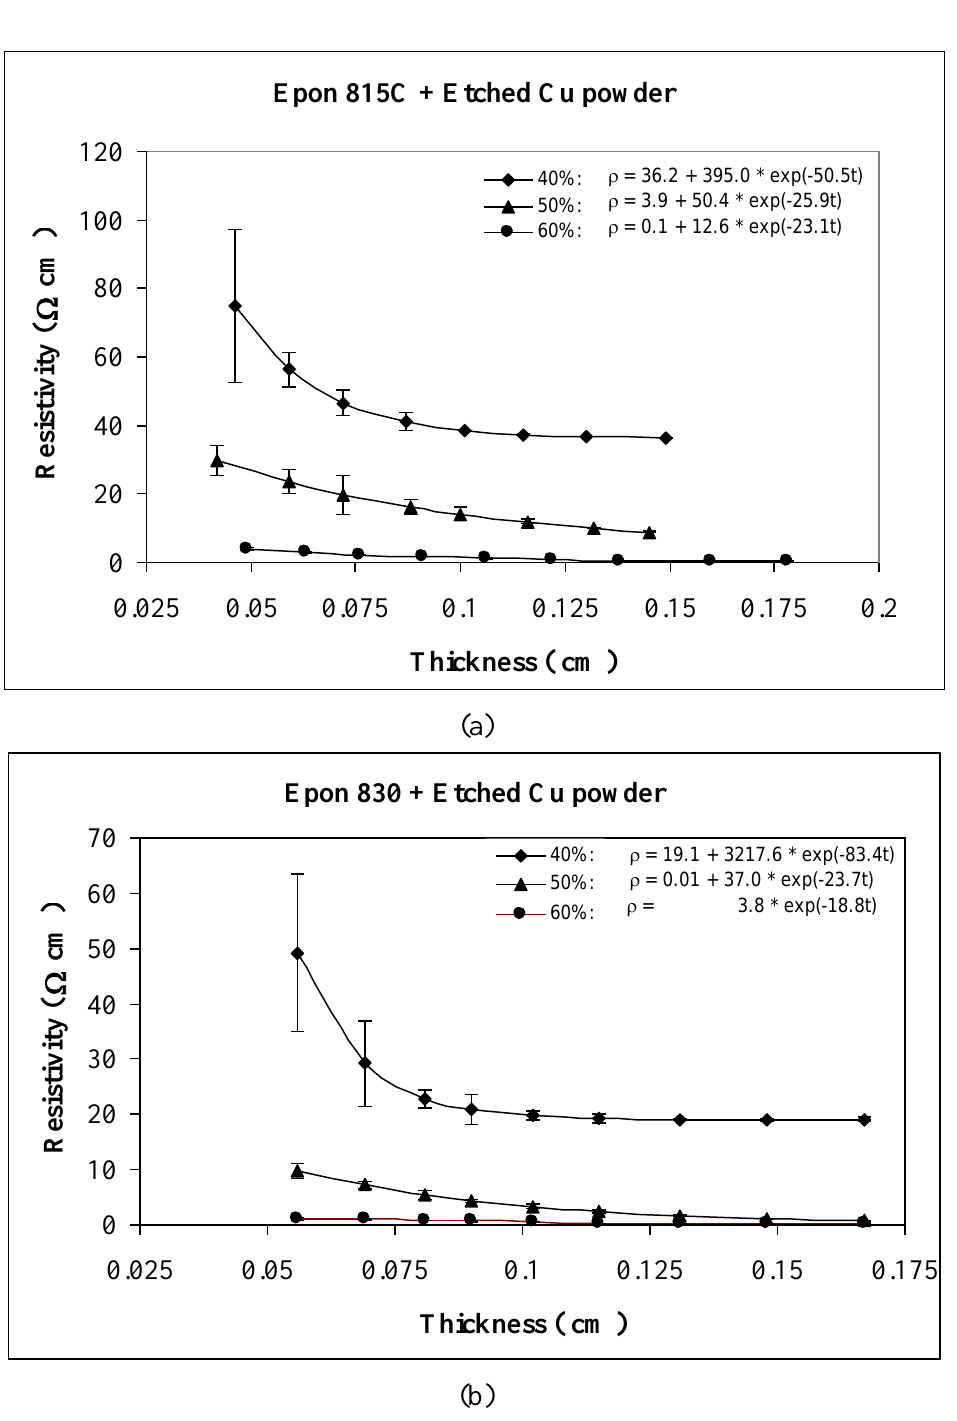
Figure 8. Thickness-dependent resistivity of Epon 815C ( a ), and 830 ( b ) films filled 40%, 50%, 60% by volume with etched copper